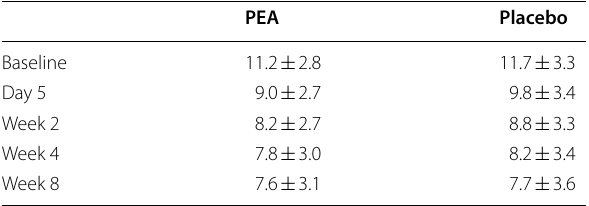
N.B. Data presented as mean